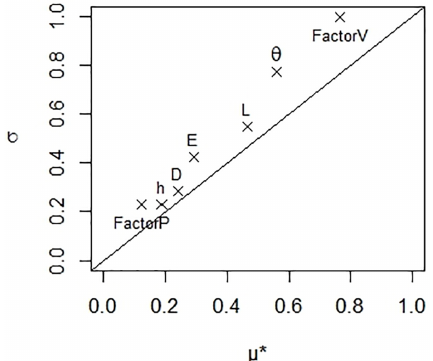
Figure 8. Sensitivity analysis of the AVrain model by the Morris (1991) method improved by Campolongo et al. (2007), where µ ∗ indicates the linear part of the total sensitivity score for each pa- rameter while σ indicates the non-linear or interactive part. In the Morris plot, D is the drop diameter, E the spacing between solar panels, FactorP is the multiplying factor for precipitations with re- spect to the reference case, FactorV is the multiplying factor for wind velocity with respect to the reference case, h is the height of the solar panels, L is their length and θ PV is their tilting angle (see Table 1 for the reference values and ranges of the parameters). The target variable of the analysis was the coefficient of variation that measures the spatial heterogeneity of rain redistribution by the so- lar panels. The tested rain event was #06 in Tables 3 and